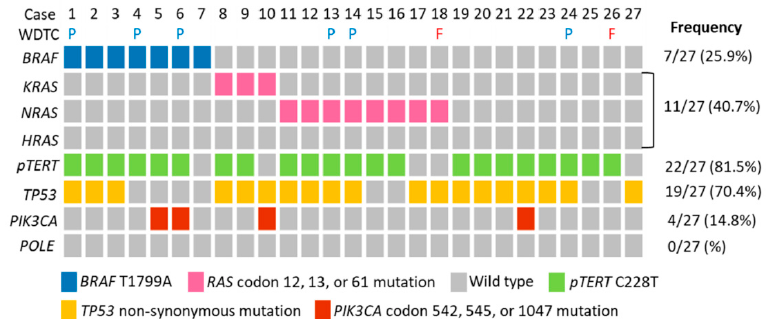
Figure 2. Summary of the mutational profile of the 27 cases of anaplastic thyroid carcinoma analyzed by next-generation sequencing and mass spectrometry. WDTC, coexisting well-differentiated thyroid carcinoma; P, papillary carcinoma; F, follicular carcinoma; pTERT , TERT promoter. Table 3. Summary of clinicopathological features of 27 anaplastic thyroid carcinoma cases with stratification by BRAF V600E and RAS mutations. BRAF RAS Non- BRAF / RAS p Value